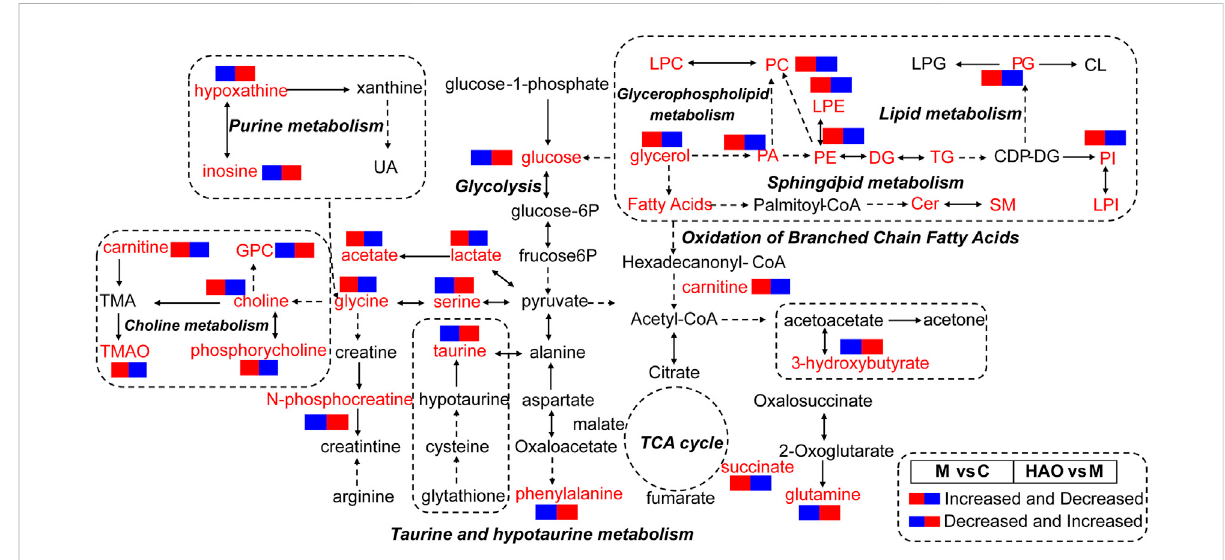
The analysis of metabolic pathway of AlismatisRhizoma extract in intervention of high fructose-inducedmetabolic syndrome inmice. (The red font represented the detected differential metabolites, the solid arrow represented one-step production, and the dotted arrow represented multiple-step